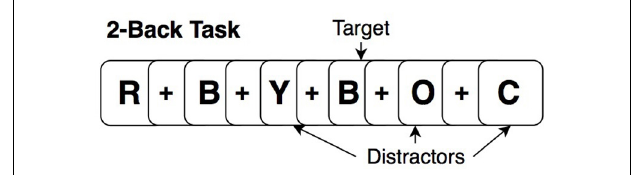
FIGURE 3 | Example of a 2-Back working memory task.